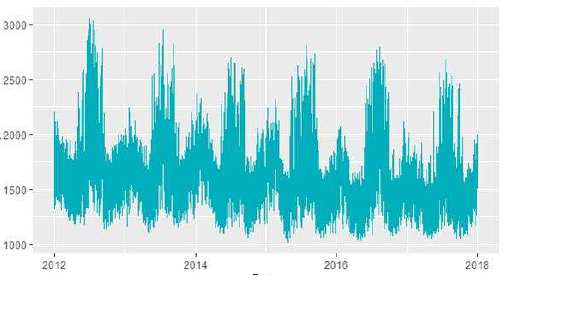
Figure 1: Hourly electricity consumption in MW,